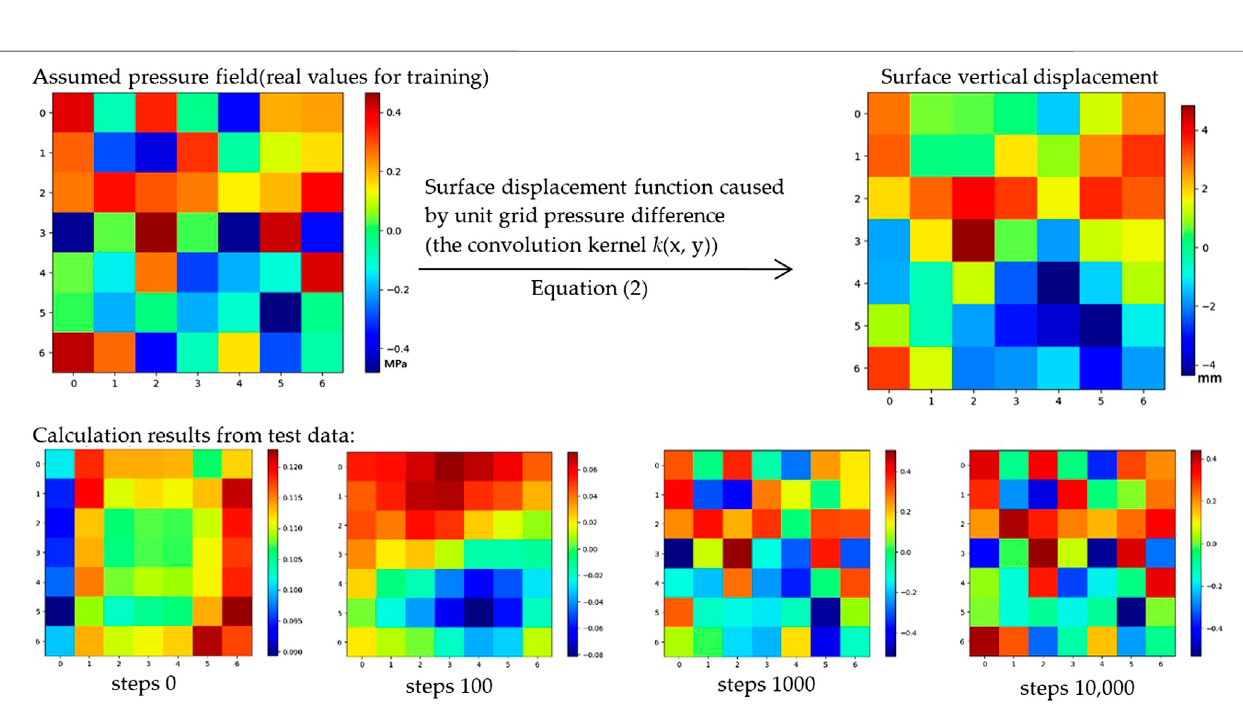
Frontiers in Earth Science |